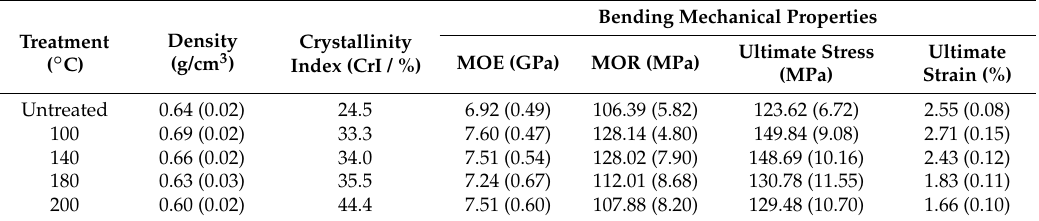
Figure 2. Flexural stress-strain behavior of bamboo composites. Table 1. The physical and bending mechanical properties of moso